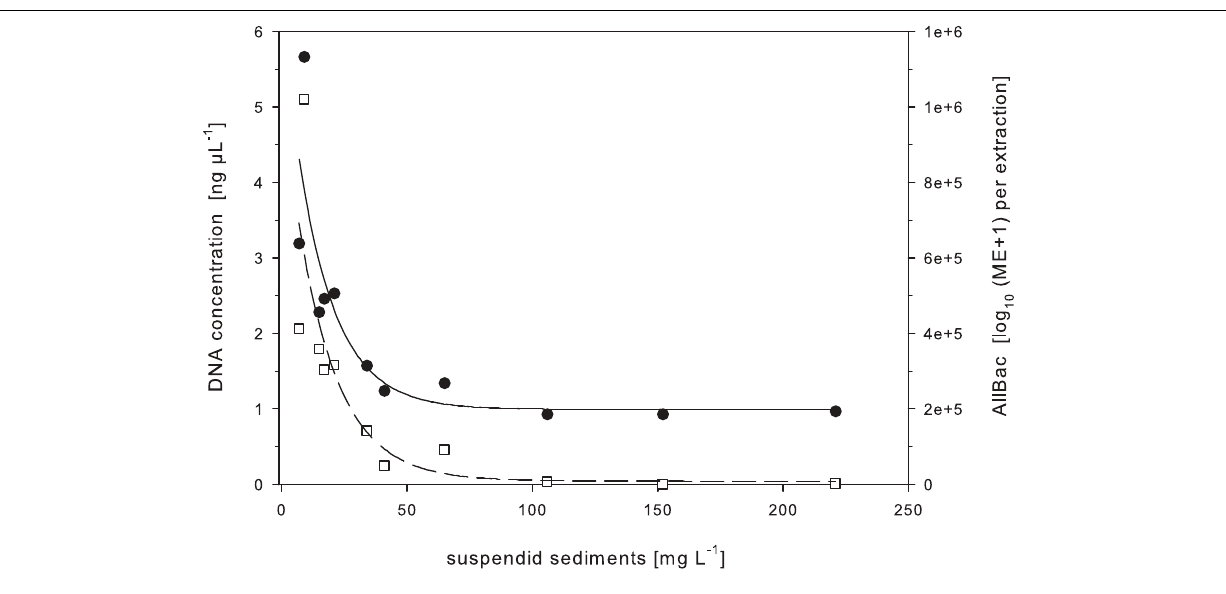
106 mg L − 1 ). The amount of salmon sperm DNA needed to reach this point, however, was different ( Figure 4